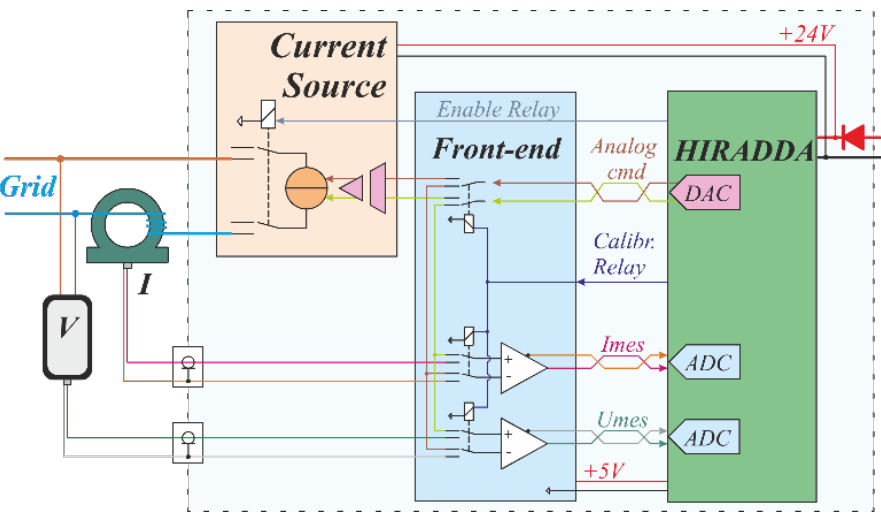
Figure 2. Block diagram of the IGOR-Meter developed by the HES-SO and setup for the grid impedance measurement.